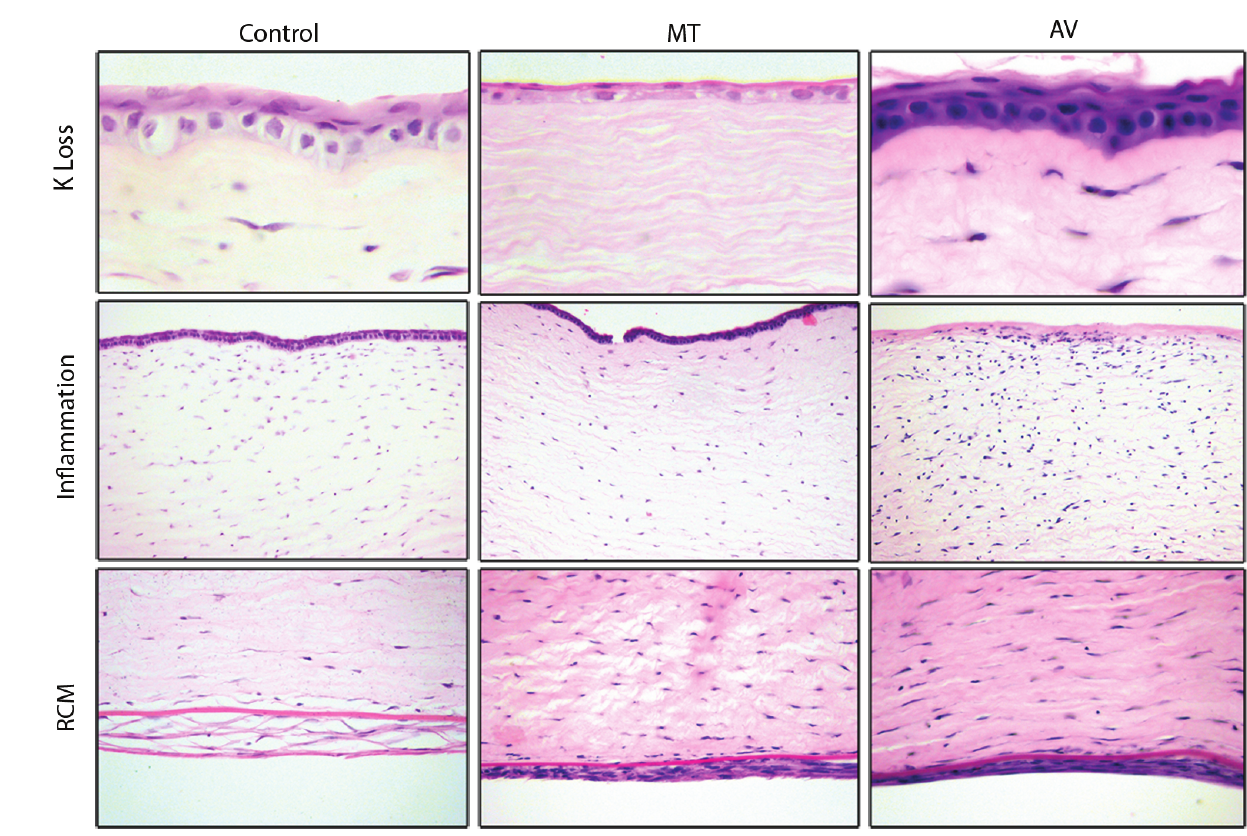
Figure 3. Histopathology of the rabbits’ corneas. Note moderate-to-severe keratocyte loss (K Loss) in the MT group compared to the mild K loss in the control and AV corneas (hematoxylin and eosin (H&E) × 1000). Moderate-to-severe stromal inflammation is present in the AV group in comparison to lower degrees of inflammation in the control and MT corneas (H&E × 200). Note the presence of a retrocorneal membrane in the control, MT, and AV corneas, showing a moderate-to-severe endothelial cell loss in all groups (H&E × 400). AV, Aloe Vera; MT, medical